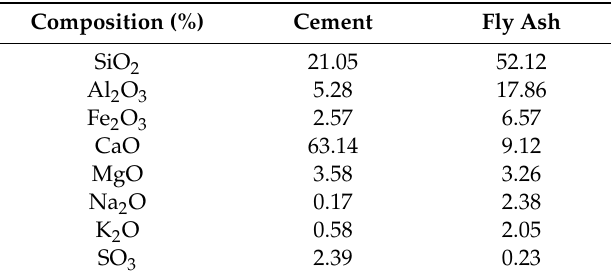
Table 1. Composition of cementitious materials.